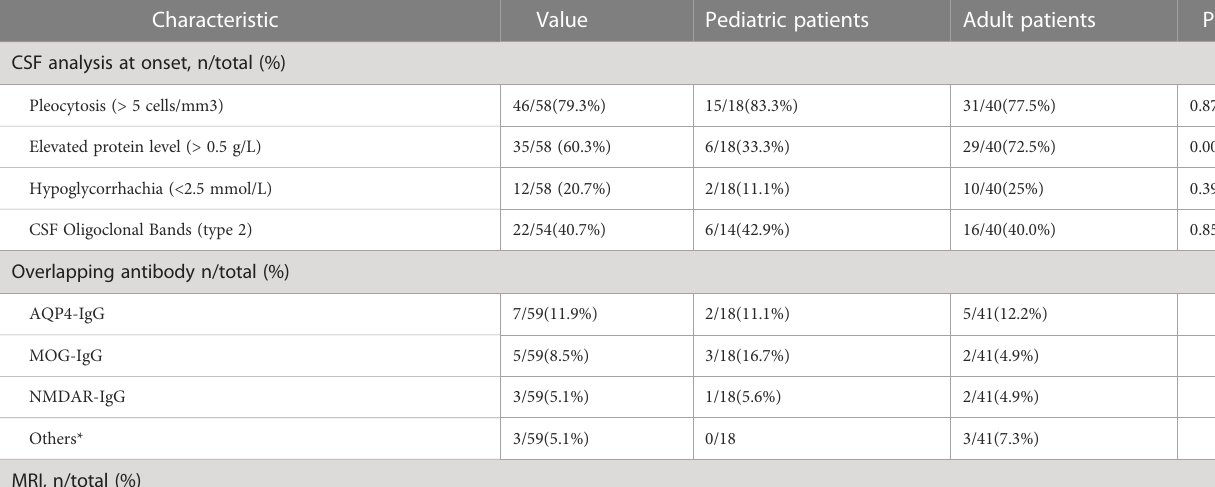
TABLE 2 Diagnostic testing and treatment of GFAP-IgG